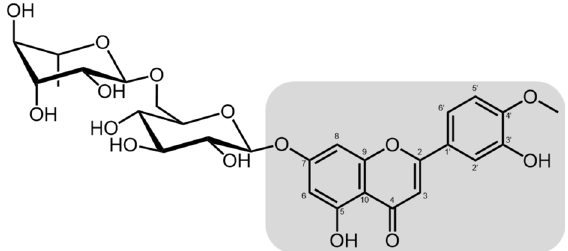
Figure 1 - Chemical structure of diosmin (diosmetin 7-O-rutinoside). The highlighted portion corresponds to the flavone constituent, which is bound to a unit of glucose, which in turn is bound to a unit of